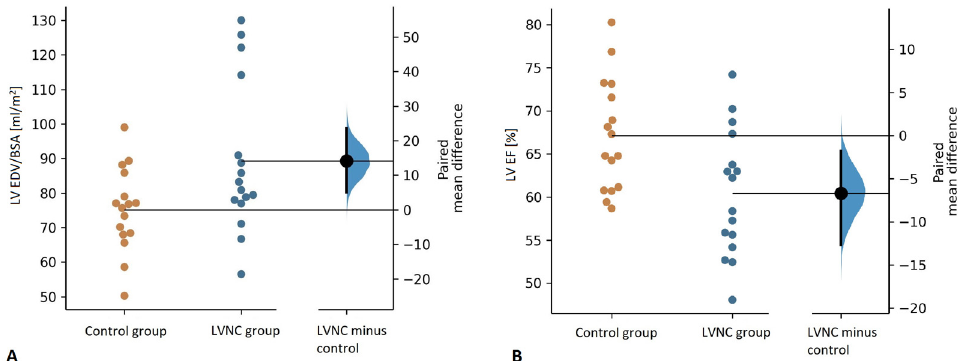
Figure 3. Comparison of the left ventricular end-diastolic volume indexed for body surface area (LV EDV/BSA) ( A ) and the left ventricular ejection fraction (LV EF) ( B ) between the control and the LVNC group.